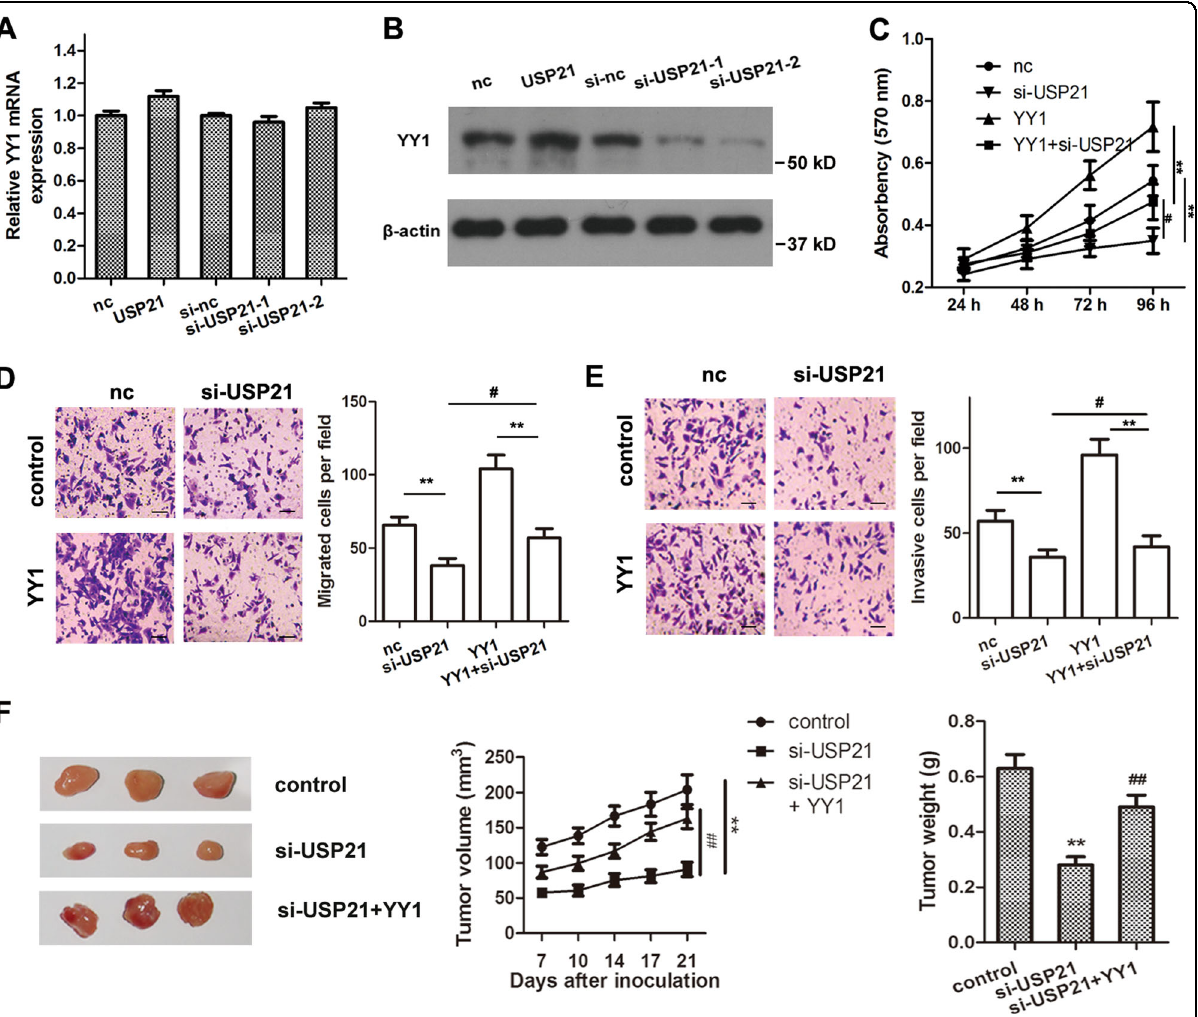
Fig. 4 USP21 plays a role as an oncogene through Yin Yang-1 (YY1). a Relative YY1 mRNA expression after upregulating or silencing of USP21. b Western blot analyses of YY1 expression after upregulating or silencing of USP21. β -Actin was used as an internal control. c Cell proliferation using the MTT assay at 24, 48, 72, and 96 h in A549 cells transfected with si-USP21- and/or YY1-overexpressing plasmid. d , e Migration and invasion assays in A549 cells transfected with si-USP21- and/or YY1-overexpressing plasmid. Representative images (left panel) and quanti fi cations (right panel) are shown. Scale bar = 100 μ m. f The tumor weights and volumes from untransfected H460 cells (control), H460 cells transfected with si-USP21 or YY1, and H460 cells cotransfected with si-USP21 and YY1. n = 5 mice per group. Error bars: mean ± SD. n = 3. ** p < 0.01 vs. the corresponding control; # p < 0.05, ## p < 0.01 vs. the si-USP21